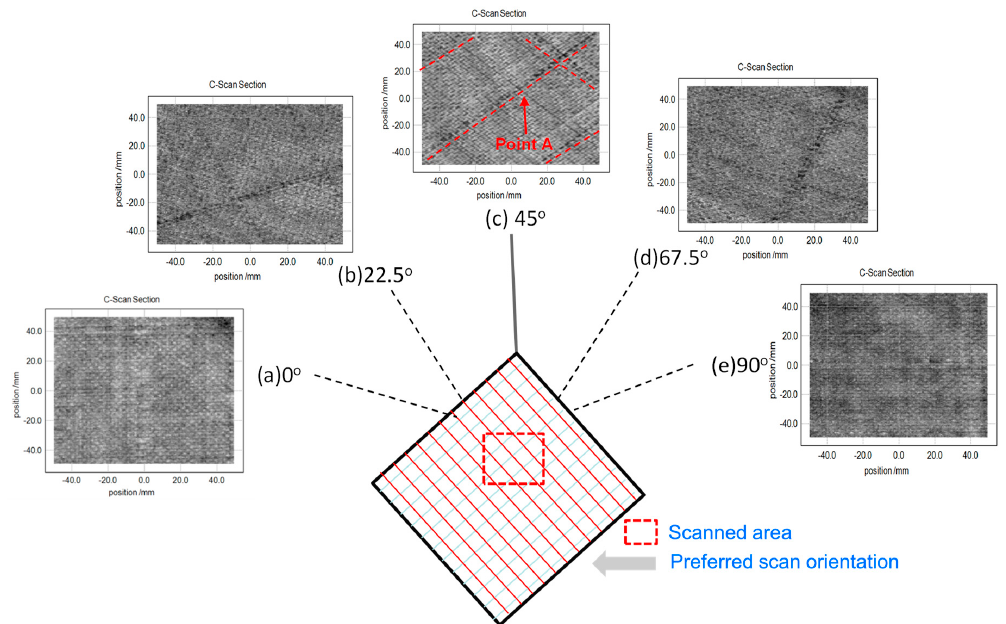
Figure 6. Terahertz scan images of the TDS reflection mode on embedded Al wires in honeycomb sandwich composite panels. ( a ) 0 ° scan image; ( b ) 22.5 ° scan image ; ( c ) 45.0 ° scan image; ( d ) 67.5 ° scan image; ( e ) 90.0 ° scan image.